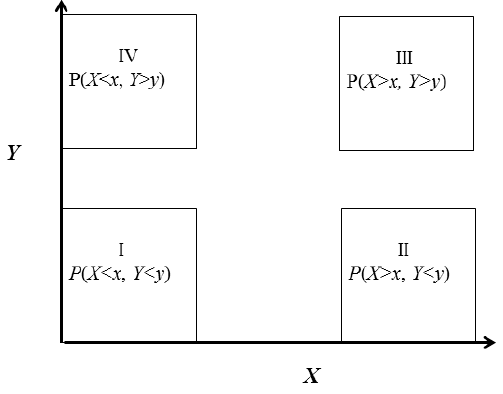
Figure 1. Different types of compound extremes in the bivariate case for two variables X and Y.